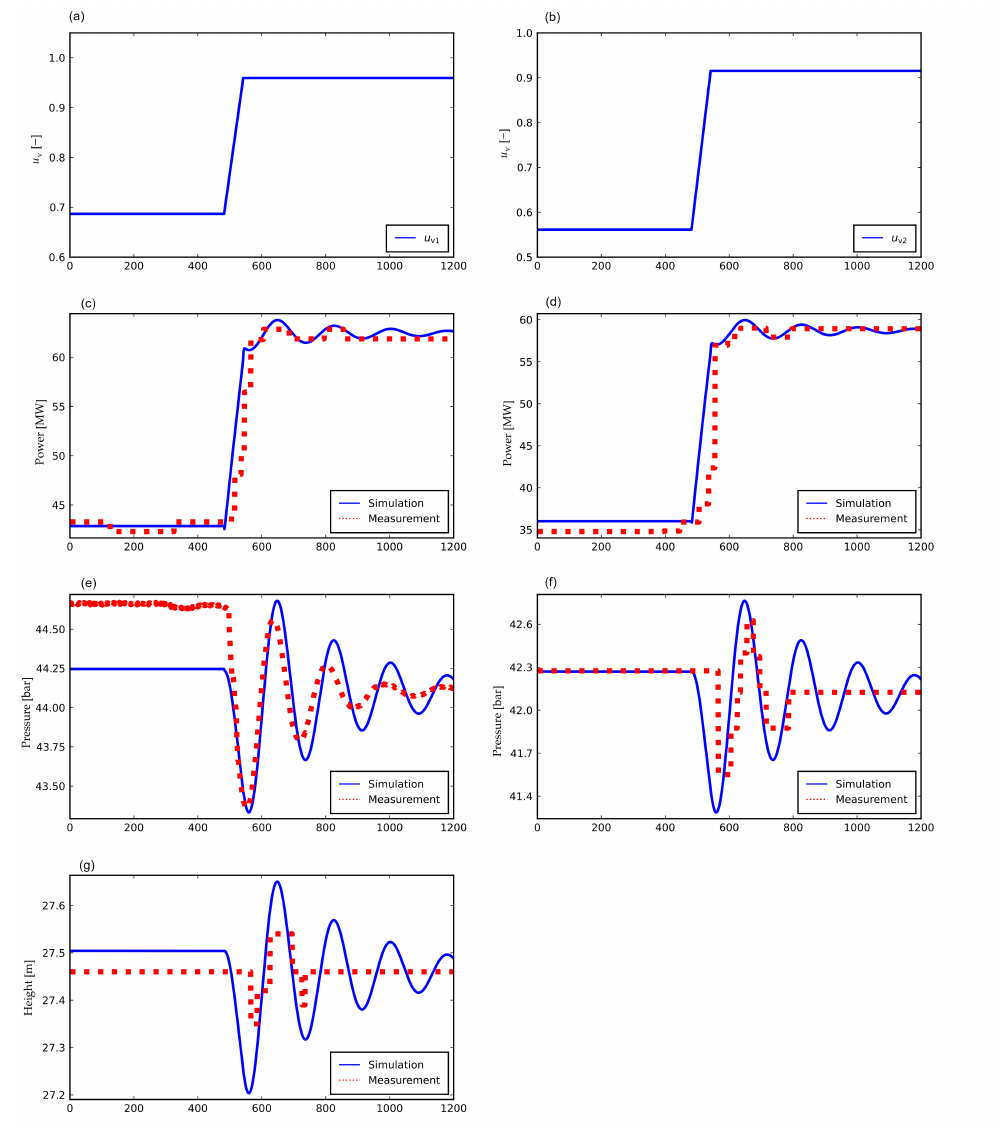
Figure 5. Simulation versus real measurements for Torpa HPP, ( a ) turbine valve signal for unit-1, ( b ) turbine valve signal for unit-2, ( c ) power output for unit-1, ( d ) power output for unit-2, ( e ) inlet pressure of the turbine units or the outlet pressure of the penstock, ( f ) air cushion pressure inside the ACST, and ( g ) height of water level inside the